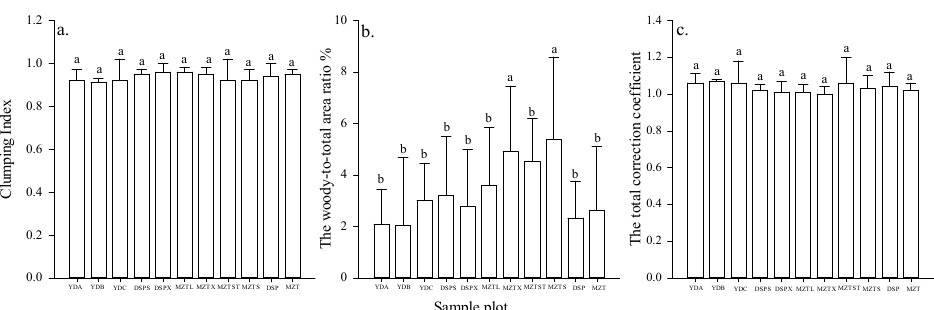
Figure 5. Correction coefficients for different sample plots. ( a ) Clumping Index; ( b ) The woody-to-total area ratio; ( c ) The total correction coefficient. Different lowercase letters (a, b) indicate significant differences between the correction coefficients of different sample plots ( p < 0.05).